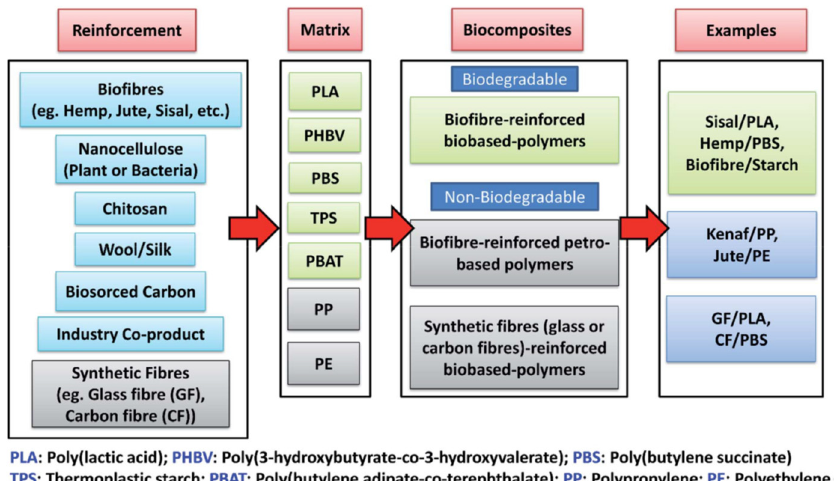
Figure 3. Types of biocomposites and examples. Figure reproduced with permission from